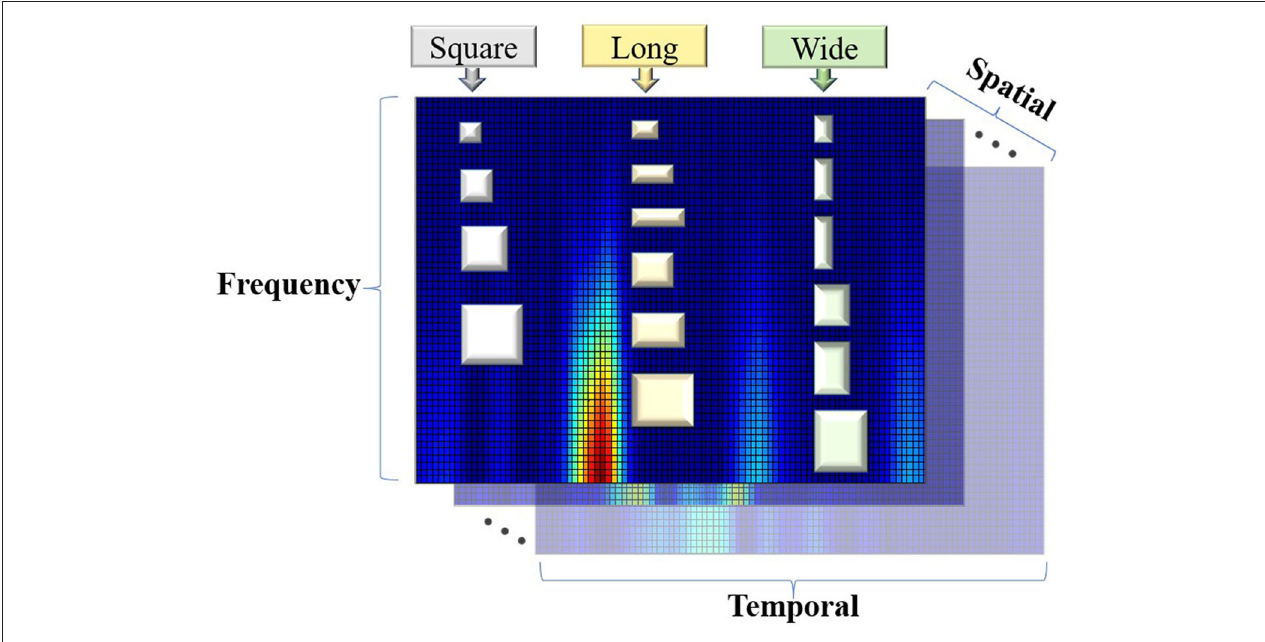
FIGURE 12 | The convolution kernel corresponds to the real size of EEG data.